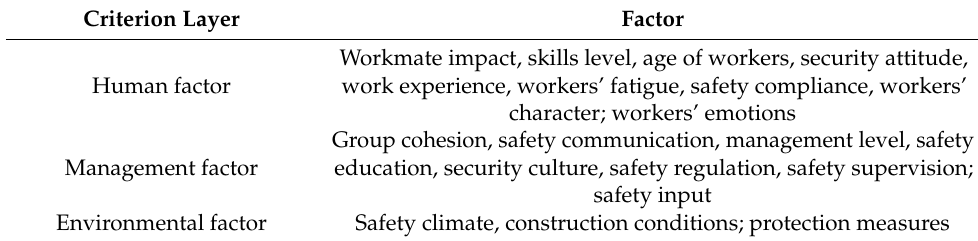
Table 6. A hierarchical structure